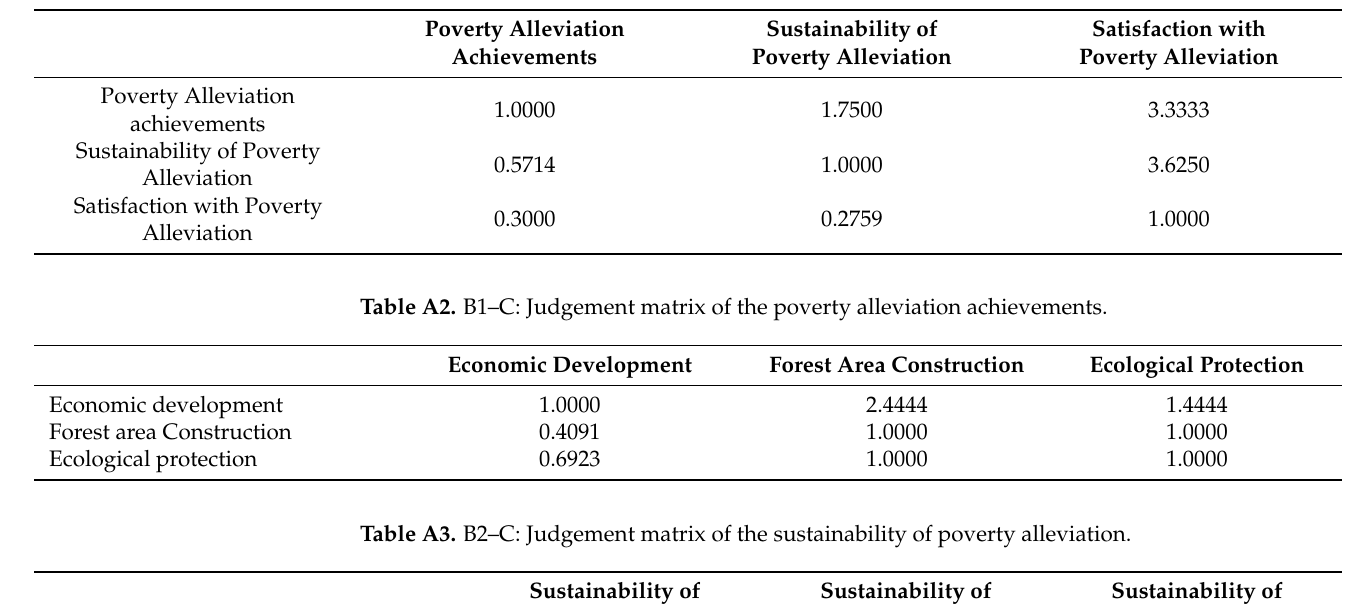
Table A1. A–B: Judgement matrix of the poverty alleviation performance through NTFPs.